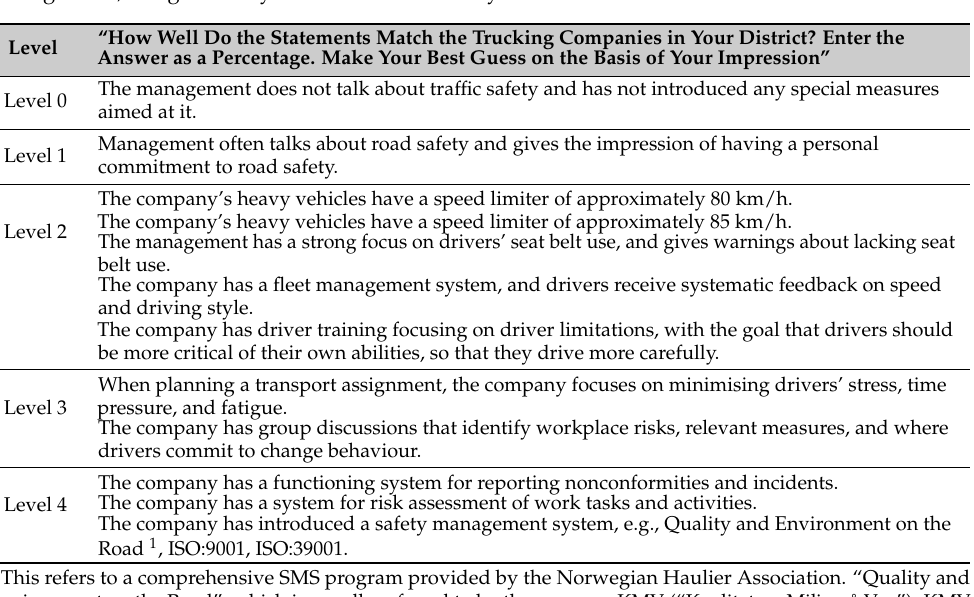
Figure 1. The Safety Ladder for safety management in goods transport. Table 1. Questions in the survey on the prevalence of measures aimed at organisational safety management, categorised by the levels in the Safety